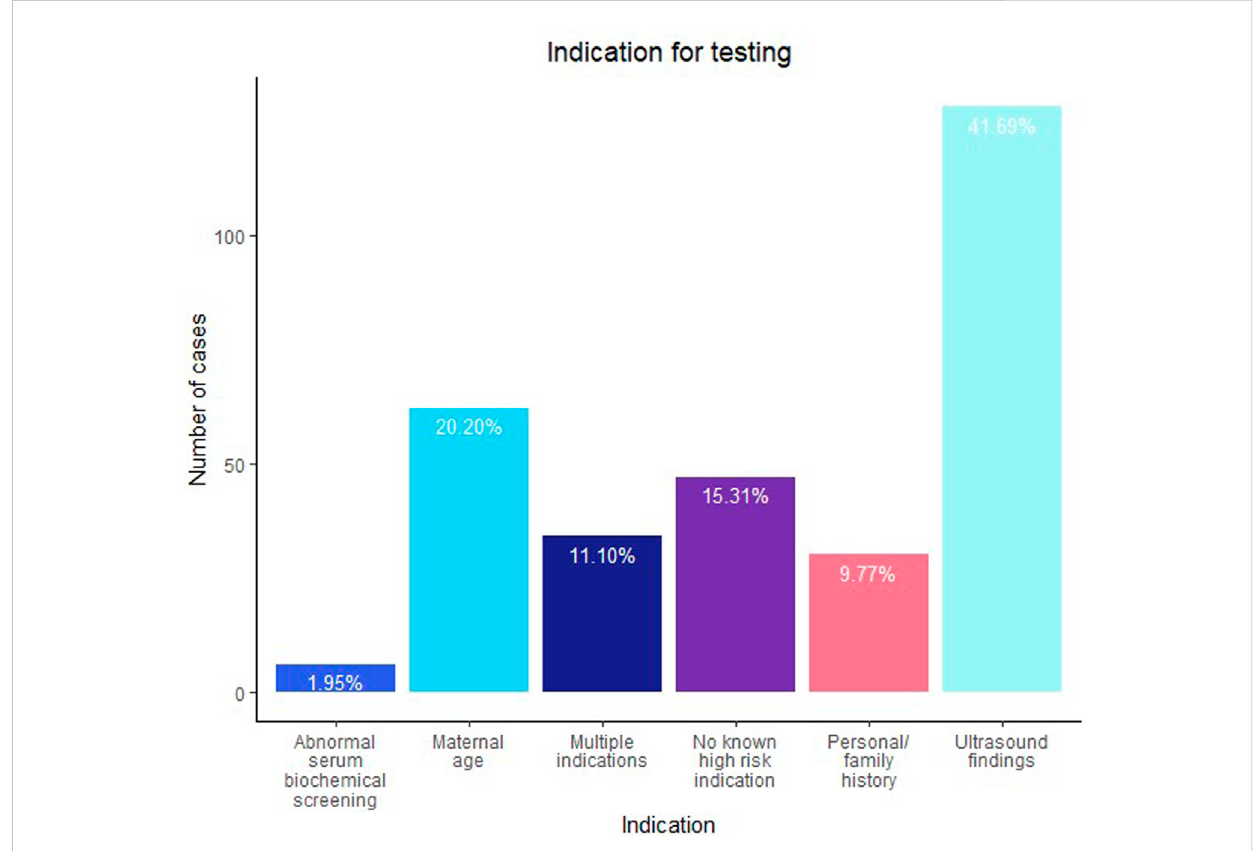
FIGURE 1 Indication for testing, as provided on the test requisition